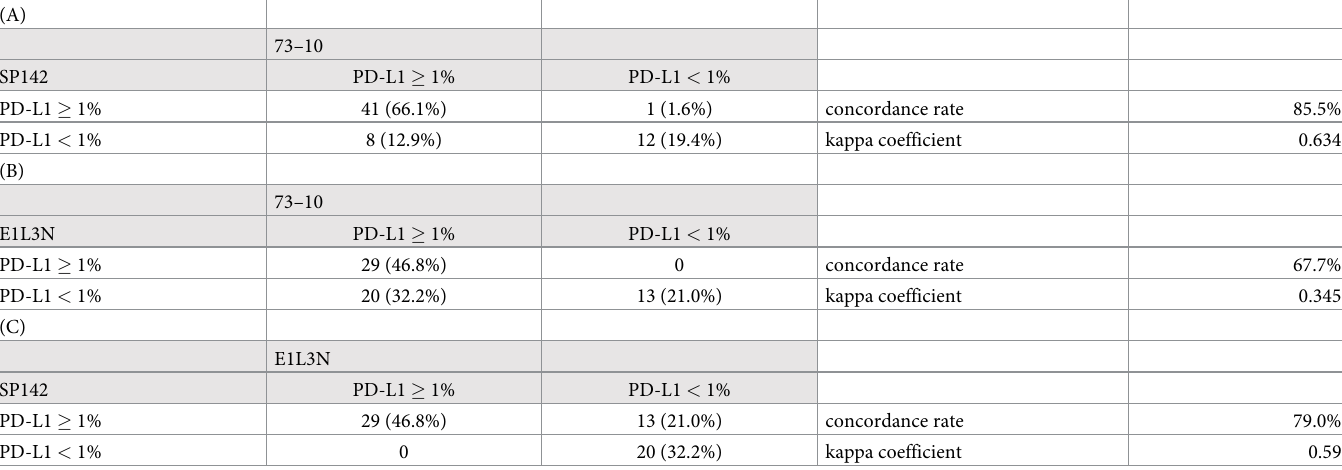
Table 2. Comparison of PD-L1 expression on ICs by 73–10, SP142, and E1L3N assays.